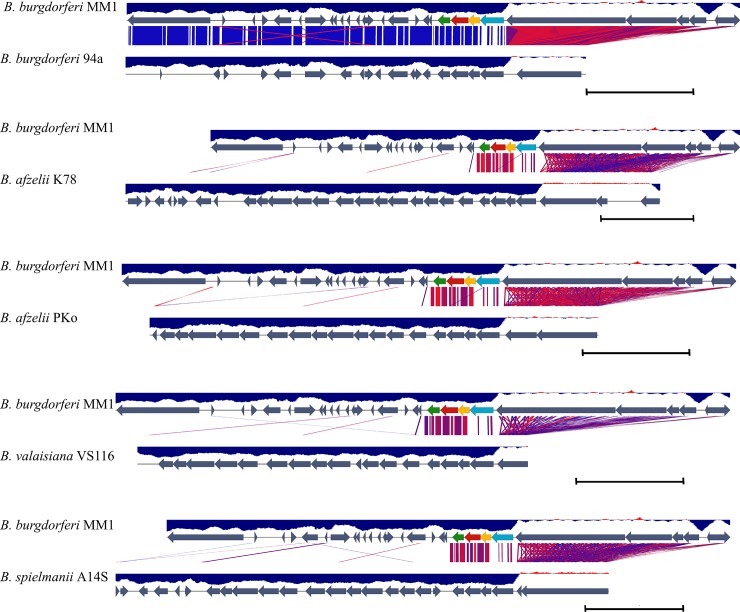
A diagrammatic depiction of the differences in the organization of the lp28-8 plasmids in MM1 and B. burgdorferi s.l. species.Annotations are represented as grey arrows. MM1 PFam organization and synteny are displayed on each alignment as red (PFam32), green (PFam49), yellow (PFam50) and blue (PFam57/62) arrows. Only PFam types with consecutive numbers are color coded. BLAST sequence comparison (E-value <0.001) represents a similarity range from 80% (red) to 100% (blue) among plasmid pairs. GC content is calculated in a window of 400 bps and displayed as a blue histogram bar of a GC content less or higher than 50%. The size of lp28-8 in B. burgdorferi s.s. 94a (largest contig), B. afzelii strain 78, B. afzelii strain PKo, B. valaisiana VS 116, and B. spielmanii A14S is 21,295, 28,638, 20715, 18022, and 24828 bps respectively. Sequences are shown in full and scale bars represent 5 kbps.